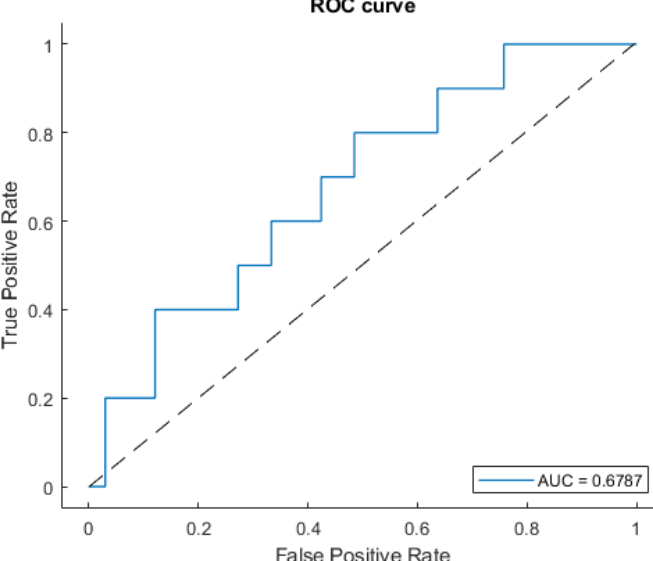
Figure 4. Model performance as a function of the increasing number of features.